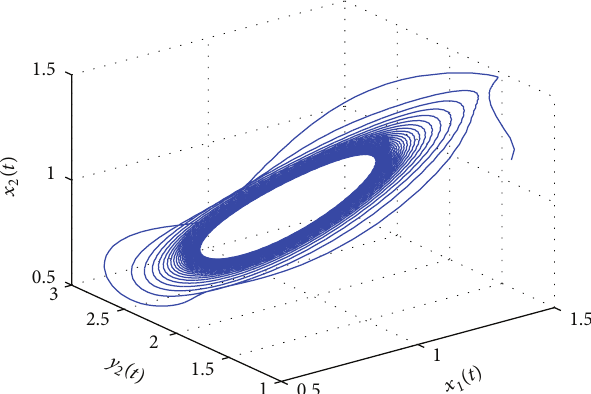
Figure 12: The phase plot of the states 𝑥 2 , 𝑦 1 , 𝑦 2 for 𝜏 2 = 10.7500 > = 9.9183 𝜏 20